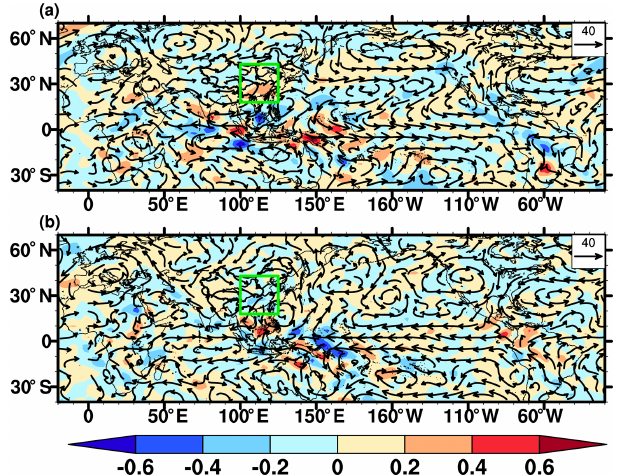
Figure 6. Vertically integrated water vapor anomalies (vector) and water vapor flux divergence (shading) composited from the lightest 25th (a) and highest 75th (b) percentile rainfall events in the dry season. The water vapor flux unit is kgm − 1 s − 1 and for the water vapor flux divergence is kgm − 2 s − 1 . The green rectangle denotes eastern